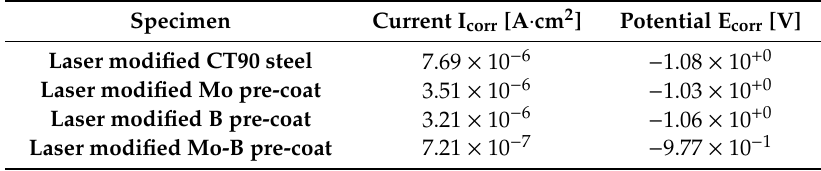
Table 5. Corrosion current and corrosion potential of CT90 steel specimens after laser heat treatment.